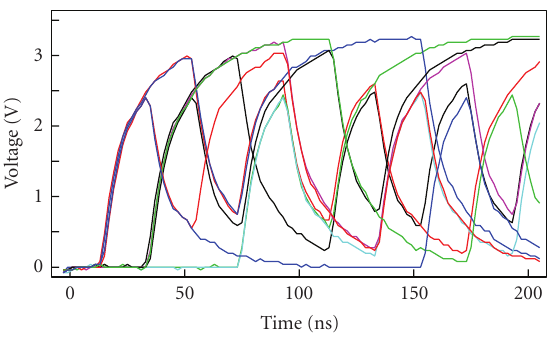
Figure 11: 10 restarts with 25 rings.